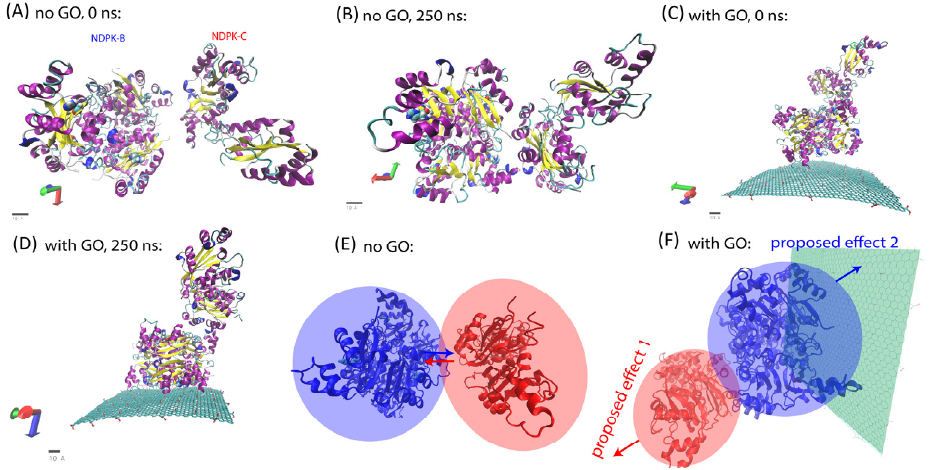
Figure 1. Trajectory screenshots and schemes of simulated systems: ( A – D ) Two systems (with